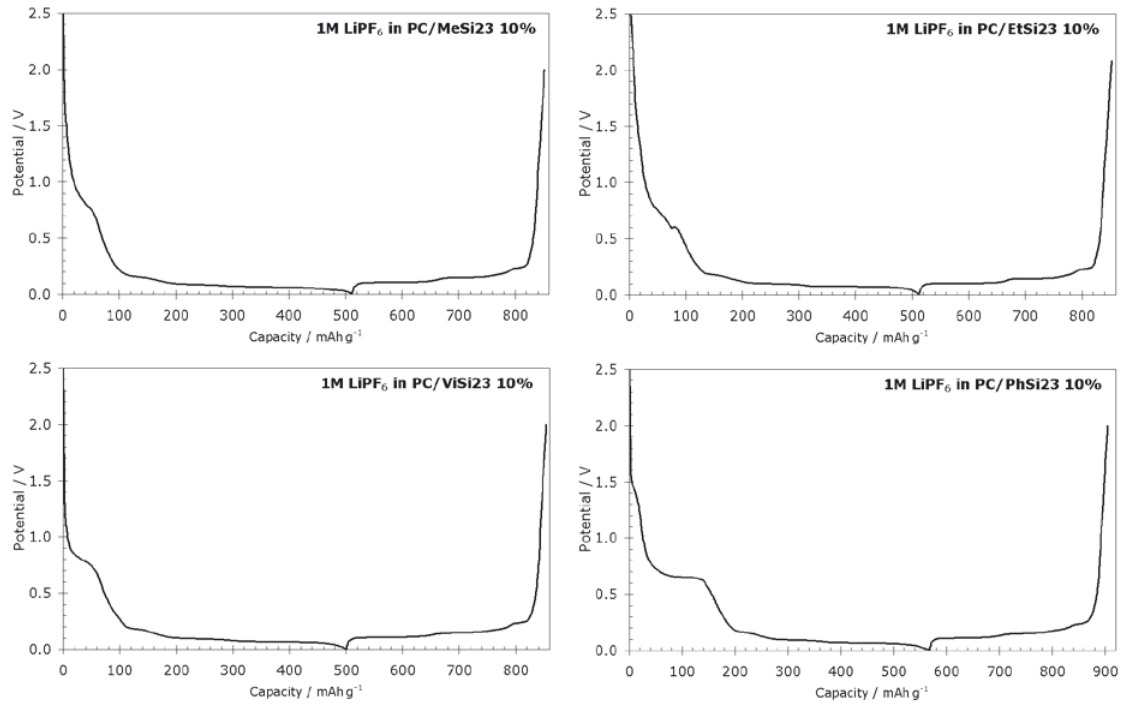
Figure 2. Galvanostatic charge/discharge curves in the first cycles recorded for graphite in PC-based electrolytes with silane additives (volume ratio PC:additive = 9:1). Table 3. Basic electrochemical parameters of the graphite anodes in the examined electrolyte compositions determined on the basis of galvano- static charge/discharge experiments; Q - charge capacity in the 1st cycle, Q - discharge capacity in the 1st cycle, Q - 1ch 1dis irr